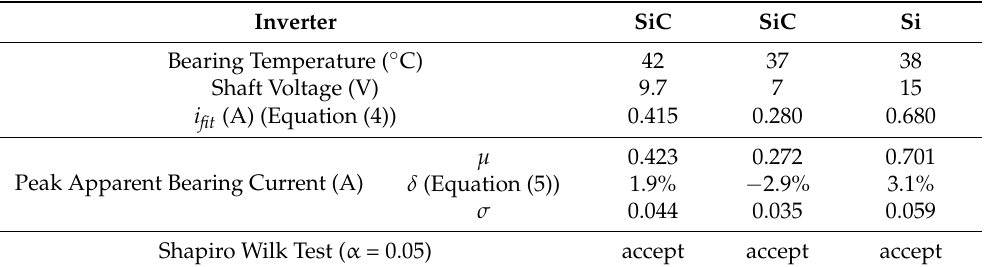
Table 2. Normal distribution statistics for peak apparent bearing current at various shaft discharge voltages for the Si and SiC inverter. Inverter SiC SiC